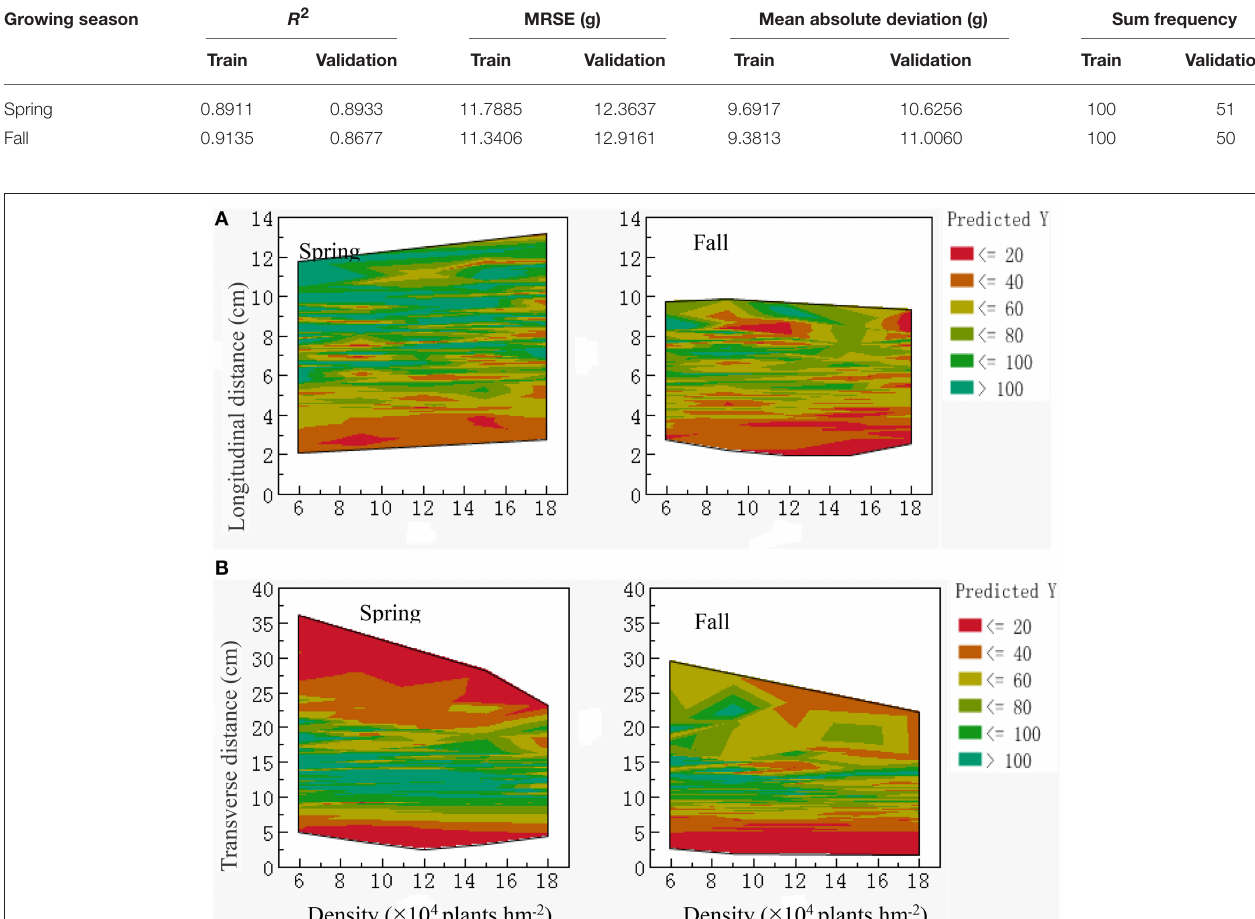
TABLE 8 | Artificial neural network model of the spatial distribution of potato tuber weight parameters during different growing seasons. Growing season R 2 MRSE (g) Mean absolute deviation (g) Sum frequency Train Validation Train Validation Train Validation Train Validation